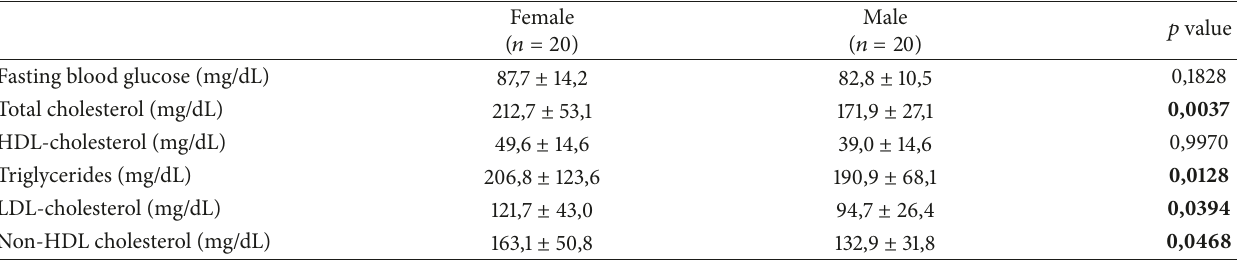
Table 2: Metabolic profile of people living with HIV/AIDS with clinical HIV-associated lipodystrophy syndrome diagnosis separated by gender.